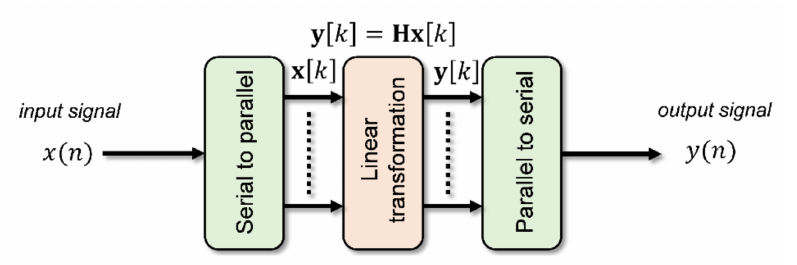
Figure 3. Scheme of sliding window filtering.